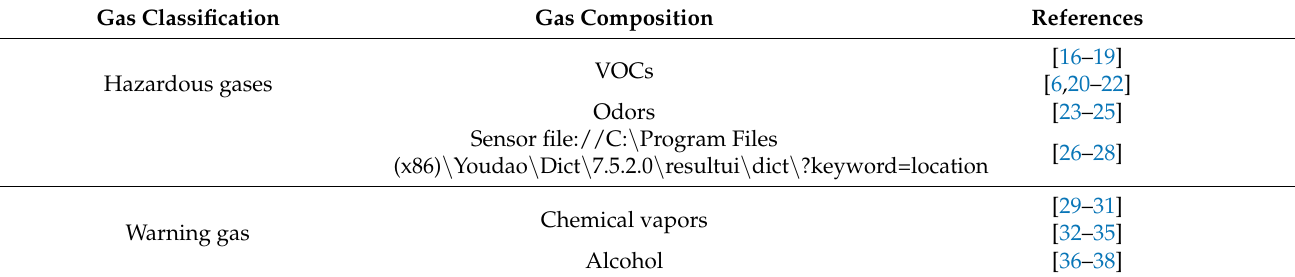
Table 1. Classification of gases in closed